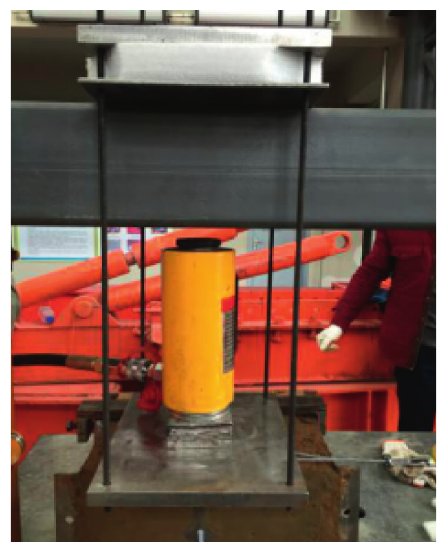
Figure 6: Vertical loading device.